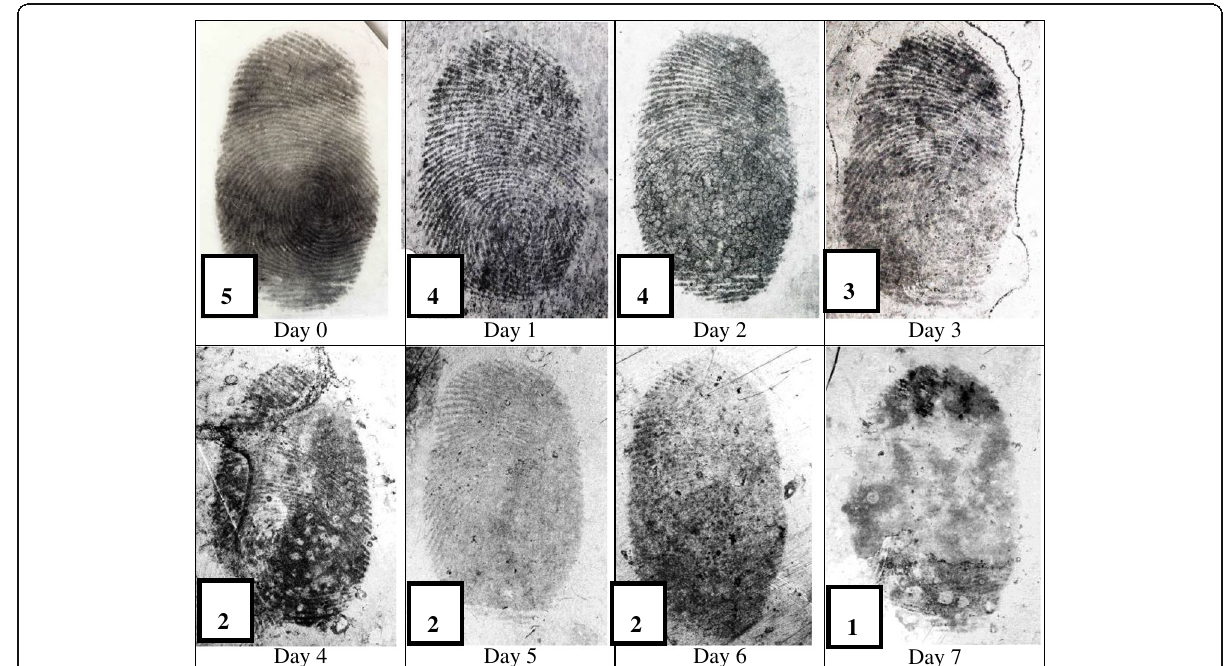
Fig. 8 Developed fingermarks using small particle